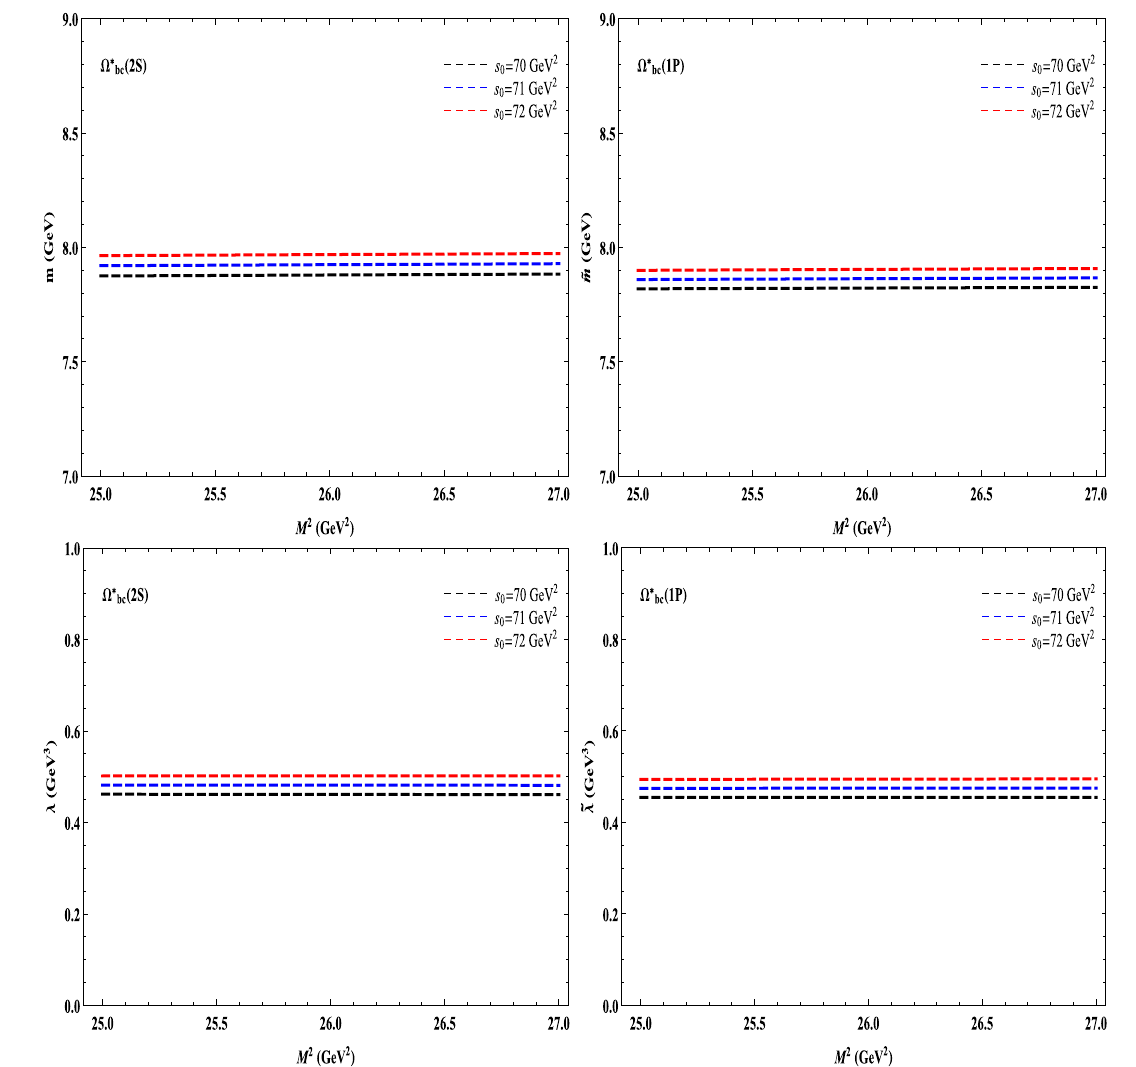
Fig. 6 The dependency of the excited states 2 S , 1 P masses, and pole residues of the doubly-heavy of spin-(3/2) (cid:3) ∗ M 2 at different values of the continuum threshold s